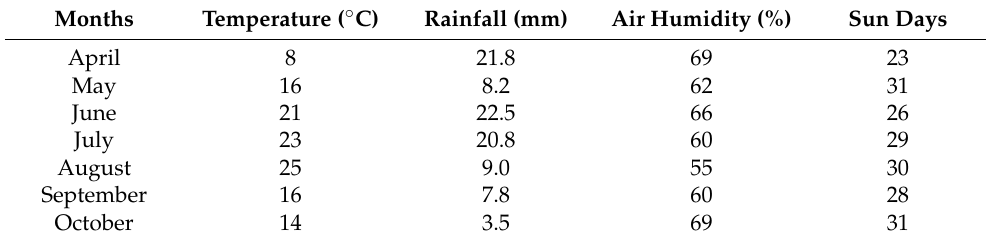
Table 6. The climatic parameters of